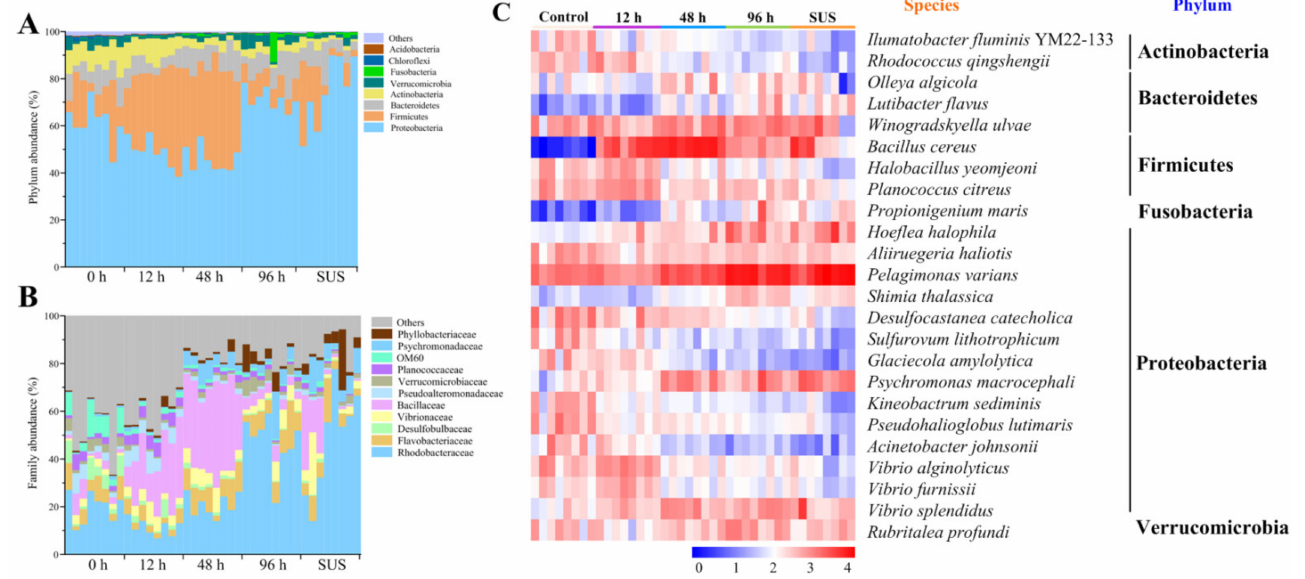
Figure 3. Bacterial taxonomic profiling at the ( A ) phylum and ( B ) family levels. ( C ) Heat map exhibiting the relative abundance (log2 transformed) of the 24 key species identified using the random forest method among the different groups after V. splendidus infection. The relative values for the bacterial species are indicated by the color